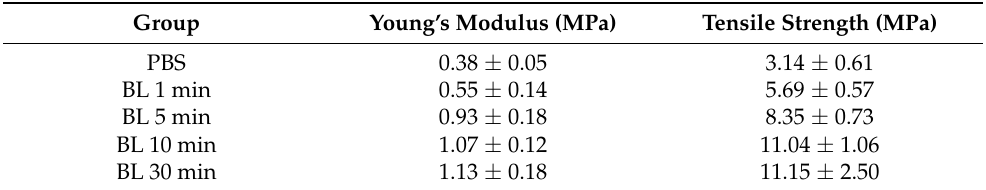
Table 3. Young’s moduli and tensile strengths of porcine skins by 0.05% RFP and different BL irradiation